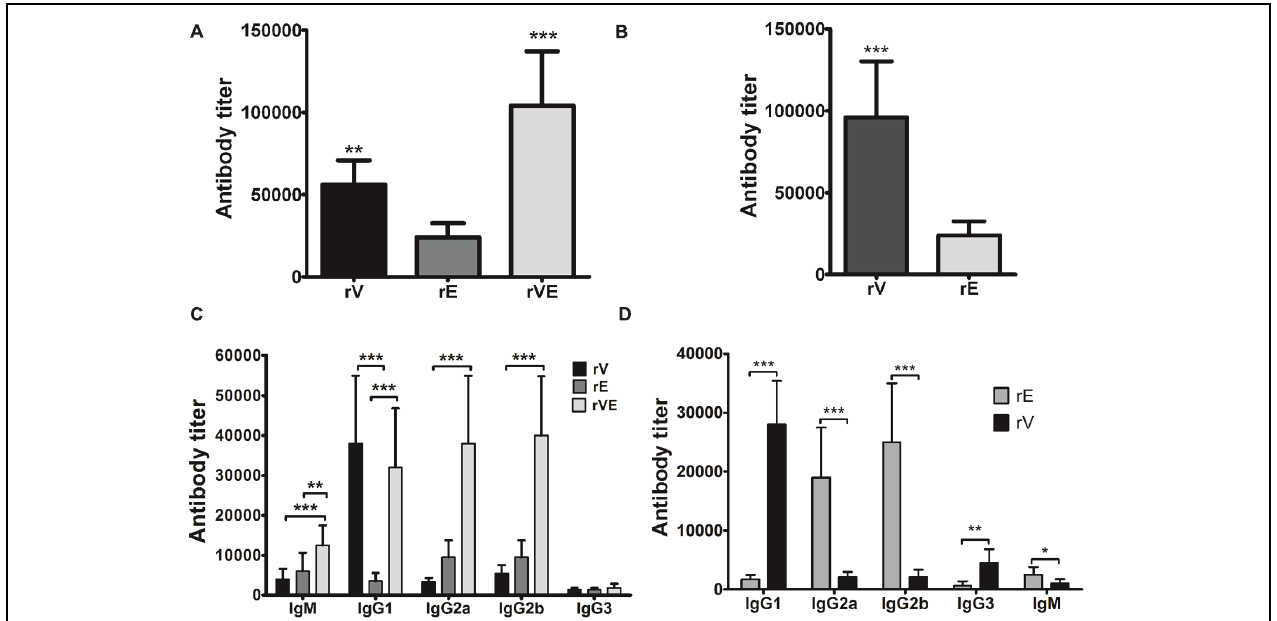
FIGURE 2 | Specific antibody response and antibody isotype profiling estimated by end point titers of murine polysera raised in immunized mice. (A) Total serum anti-rV, anti-rE and anti-rVE antibody titers assessed after 42nd day of immunization. (B) The proportion of rV and rE specific serum antibody titers in rVE immunized mice after final immunization at 42nd day. (C) Specific antibody subclasses in sera of BALB/c mice immunized with recombinant protein rV, rE, and rVE at 43rd day. (D) rV and rE specific antibody subclasses in rVE immunized mice. Results are expressed as antibody titer, the maximum dilution of serum having OD twofolds higher than sham mice polysera. The data are representing as mean value ± SD ( n = 8). ∗ P < 0.05; ∗∗ P < 0.01; ∗∗∗ P <